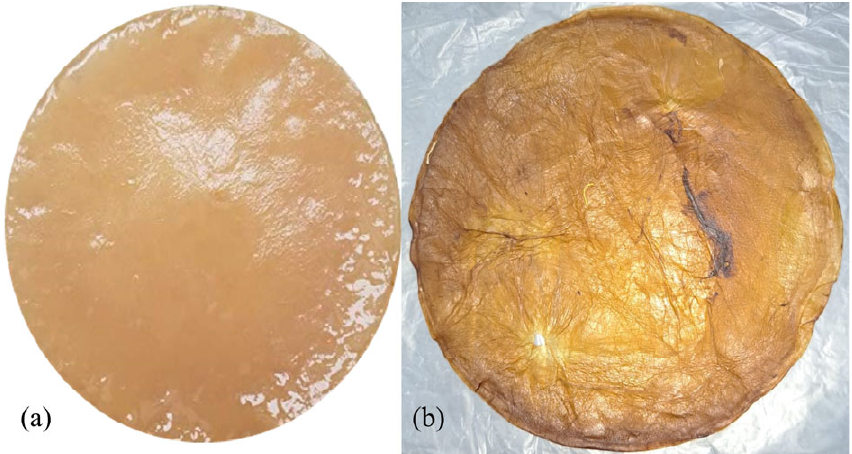
Figure 1. Appearance of: ( a ) Wet BC, and ( b ) dry BC films produced in a culture media based on green tea after 12 days of fermentation at 25 °C.